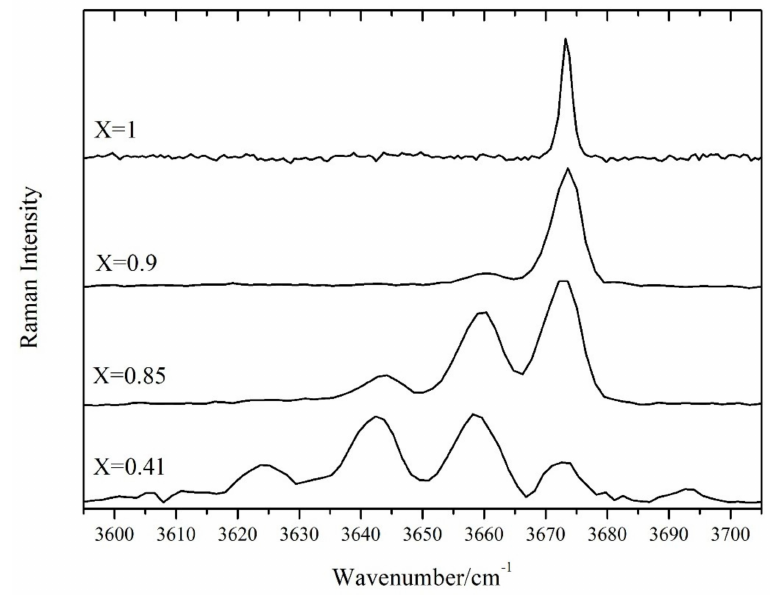
Figure 4. Raman spectra at high wavenumbers of minerals of tremolite Fe-actinolite series with di ff erent X